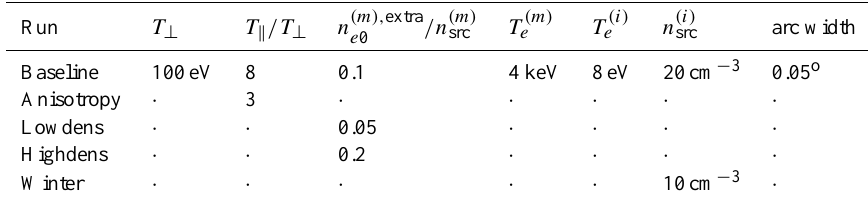
Table 1. Run input parameters